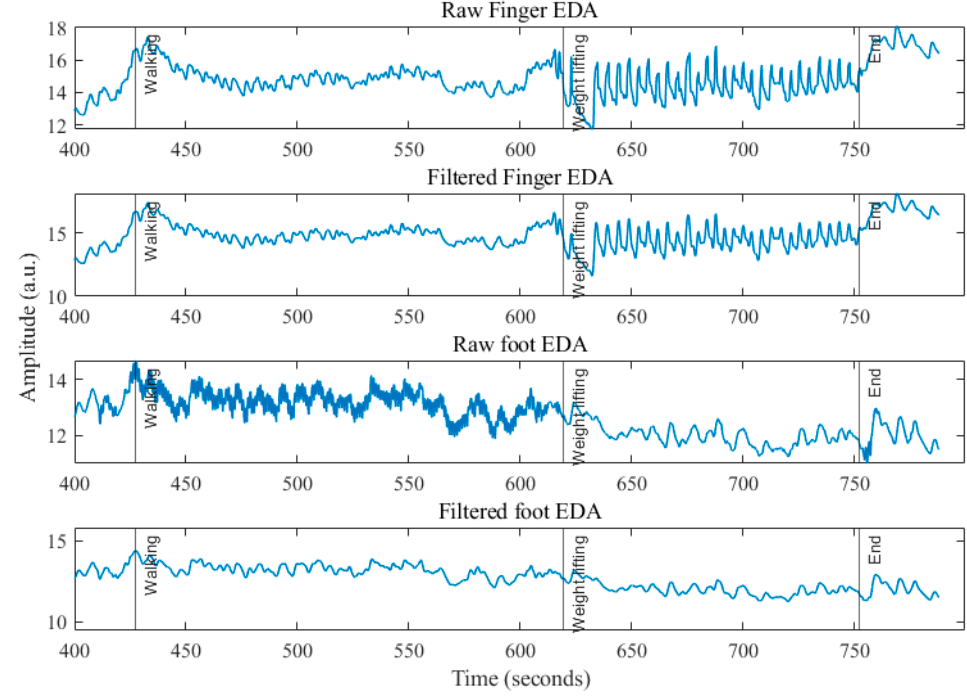
Figure 5. Raw and filtered EDAs (finger and foot) during walking and weightlifting.